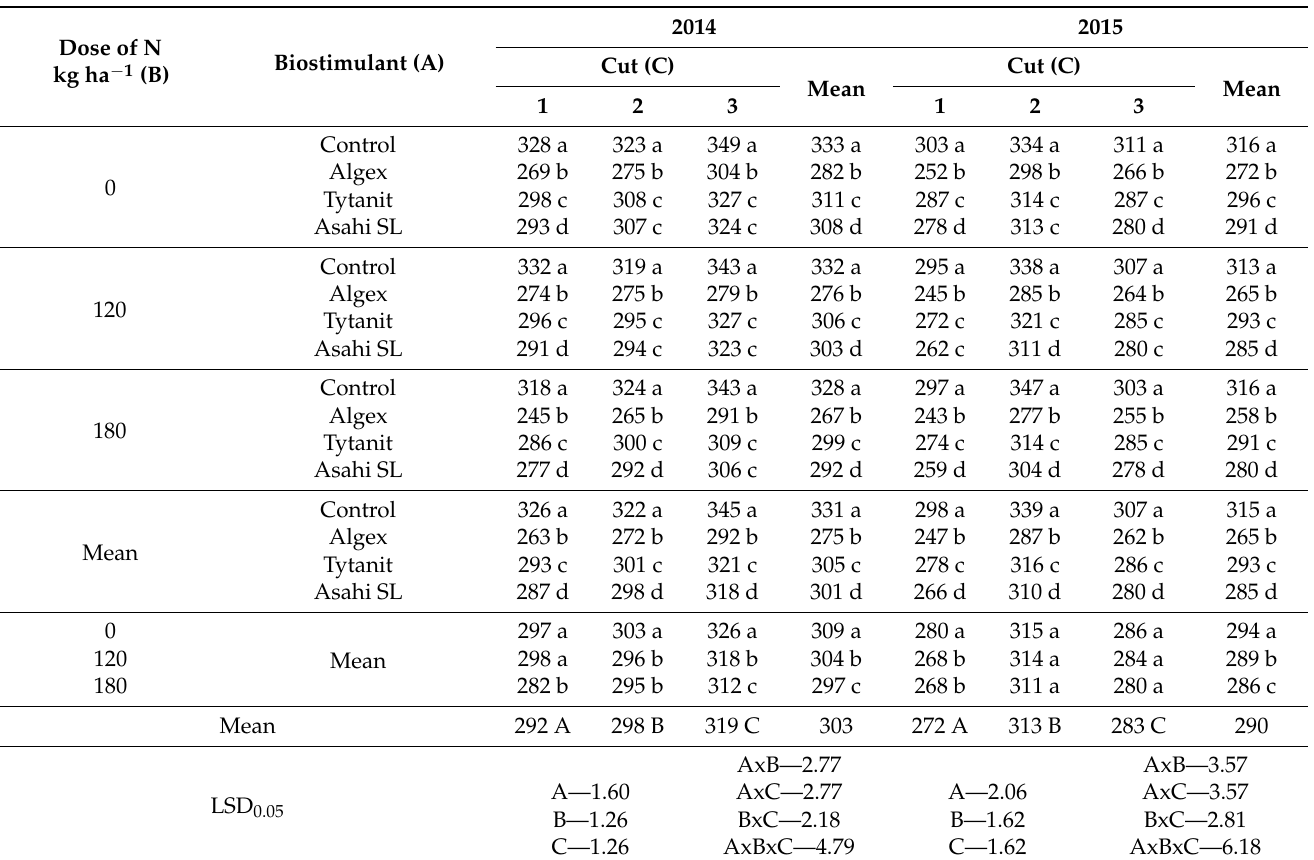
Table 3. The effect of the biostimulants on content of acid detergent (ADF) in Italian ryegrass by cut and nitrogen fertilization (g kg − 1 DM). Dose of N kg ha − 1